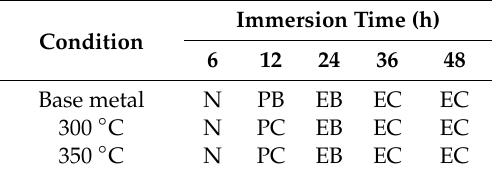
Figure 6. The cross-sectional view of ( a ) base metal, the treated samples under ( b ) 300 °C and ( c ) 350 °C after intergranular corrosion. Table 2. Evolution of exfoliation corrosion grade with immersion times for 7N01 aluminum alloy in di ff erent